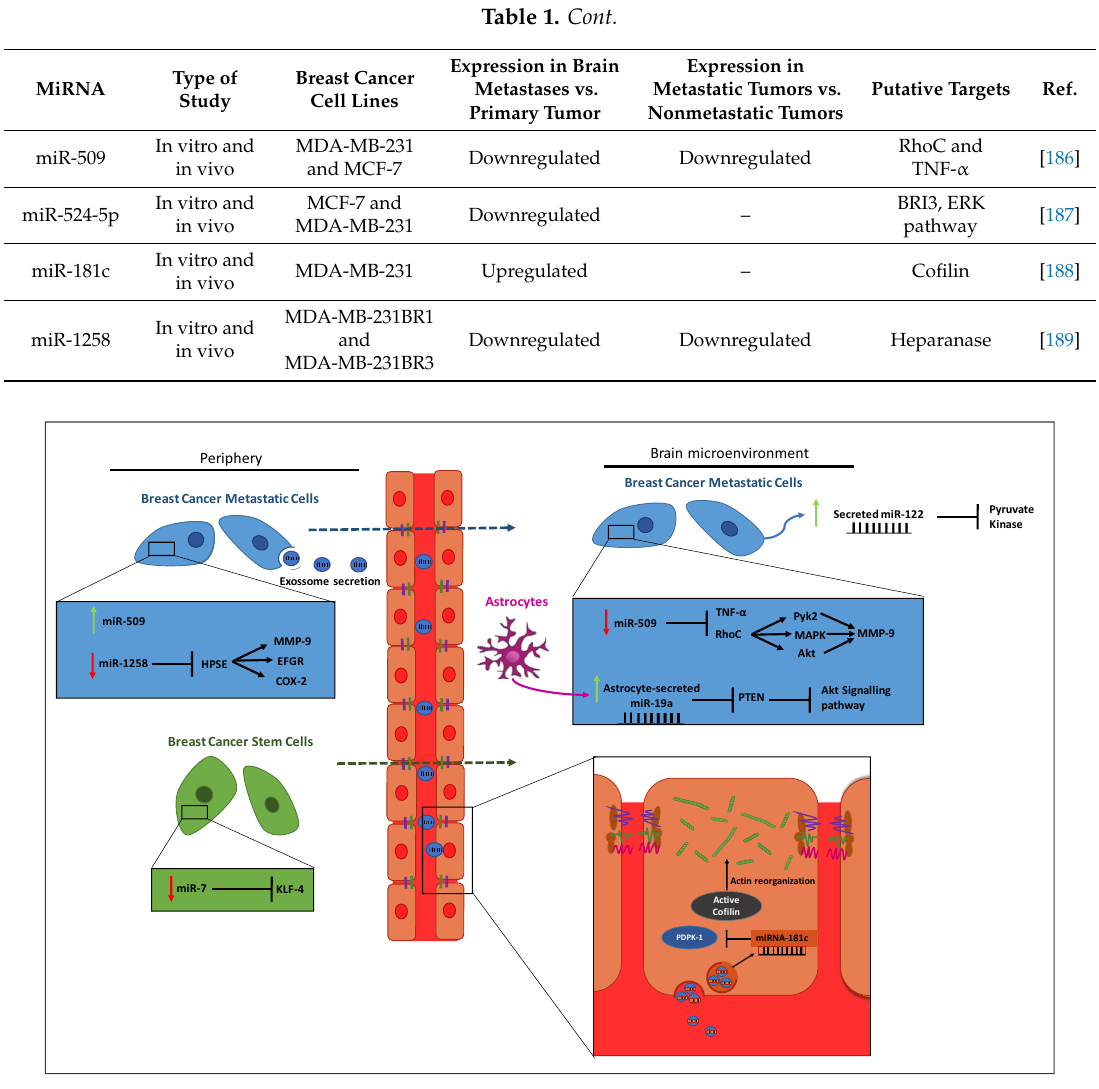
Figure 2. MicroRNAs (miRNAs; miR) currently associated with breast cancer brain metastases. Changes in the expression of miRNAs that have been correlated with the metastatic process, as well as their putative targets, are shown in different types of cells, including breast cancer cells, breast cancer stem cells, endothelial cells and cells in the brain microenvironment, namely astrocytes, are shown. While some miRNAs act intracellularly, other are released, either directly to the extracellular environment or encapsulated by exosomes that can then be transported to further places. In the insets, the intracellular mechanisms are schematized. It is known that miR-122 acts in the pre-metastatic niche, but the specific types of cells were not described yet.